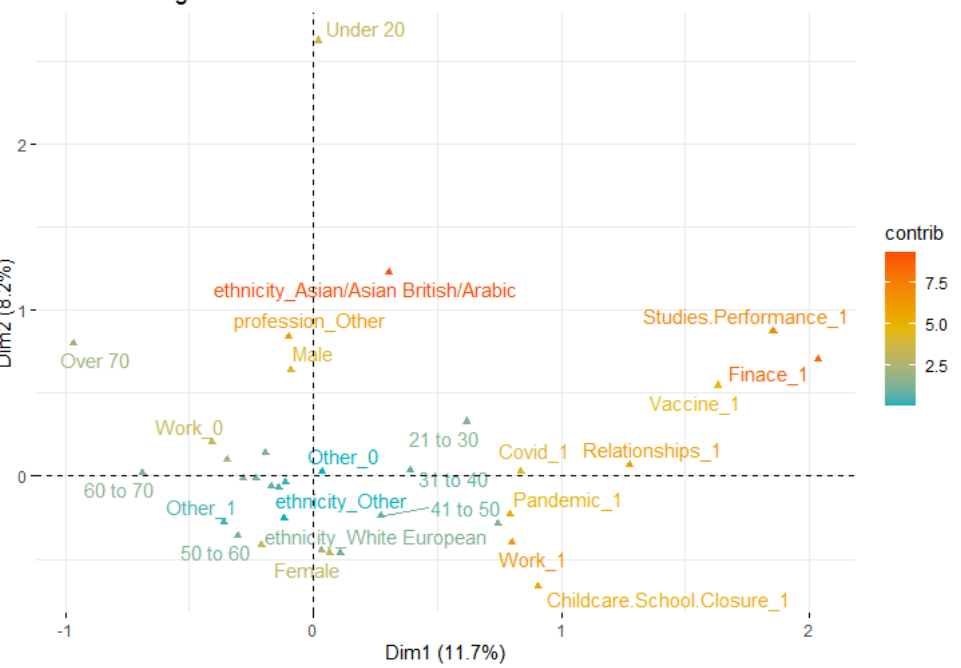
Figure 5. MCA outcomes (first two dimensions) for the combined visualisation of major stress causes and sociodemographic attributes (ethnicity, profession, sex, and age